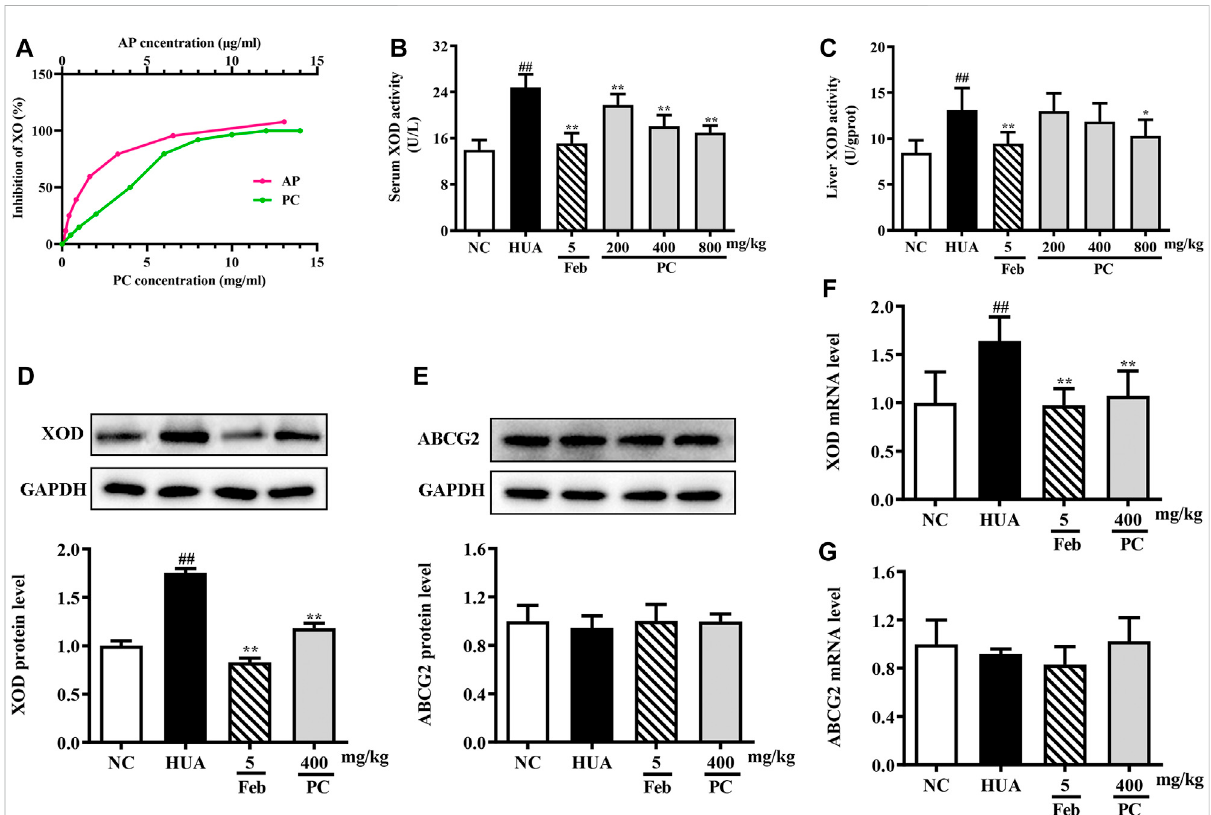
FIGURE 8 Effects of CP on XOD activity and ABCG2 expression. (A) In vitro XOD inhibition. (B) Serum XOD activity. (C) Liver XOD activity. (D) Relative protein expression levels of hepatic XOD. (E) Relative protein expression level of renal ABCG2. (F) Relative mRNA level of hepatic XOD. (G) Relative mRNA level of renal ABCG2. The protein expression level was determined by Western blotting and the relative gene level was determined by RT- qPCR. The results are expressed as mean ± SD ( n = 10). ## p < 0.01 compared with NC group; * p < 0.05, ** p < 0.01 compared with HUA